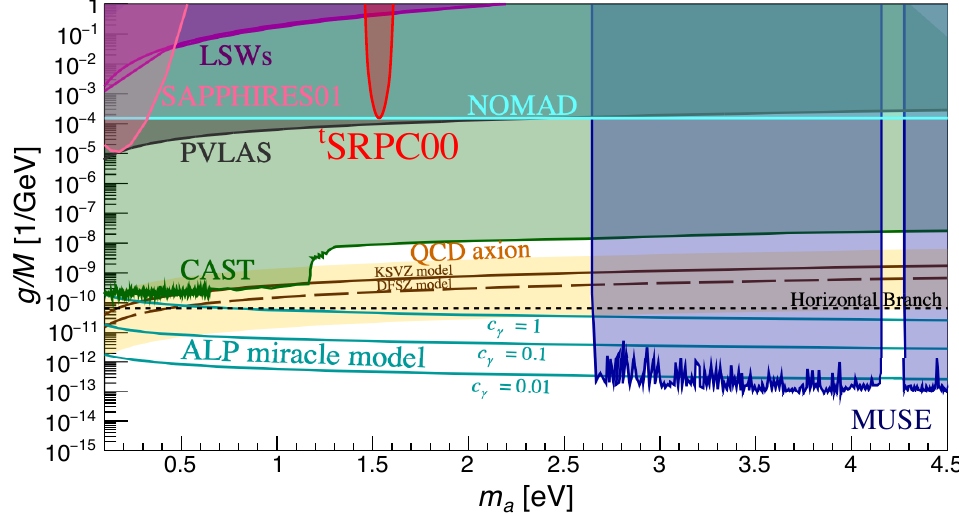
Figure 10. Upper limit in the parameter space of the coupling-mass relation (region enclosed by the red solid curve) evaluated at a 95% confidence level for the pseudoscalar field exchange achieved by the three-beam stimulated resonant photon collider ( t SRPC00). The magenta area indicates the excluded range based on SRPC in quasi-parallel collision geometry (SAPPHIRES01) [23]. The purple areas are excluded regions by the Light Shining through a Wall (LSW) experiments (ALPS [27] and OSQAR [28]). The gray area shows the excluded region by the vacuum magnetic birefringence (VMB) experiment (PVLAS [29]). The light-cyan horizontal solid line indicates the upper limit from the search for eV (pseudo)scalar penetrating particles in the SPS neutrino beam (NOMAD) [30]. The horizontal dotted line indicates the upper limit from the Horizontal Branch observation [31]. The blue areas indicate the excluded regions from the optical MUSE-faint survey [32]. The green area is the excluded region by the helioscope experiment CAST [33–36]. The yellow band and the upper solid brown line are the predictions of QCD axion by the KSVZ model [3,4] with 0.07 < | E / N − 1.95 | < 7 and E / N = 0, respectively. The bottom dashed brown line is the prediction from the DFSZ model [13,14] with E / N = 8/3. The cyan lines are the predictions from the ALP miracle model [12] with the intrinsic parameter values c γ = 1,0.1,0.01,